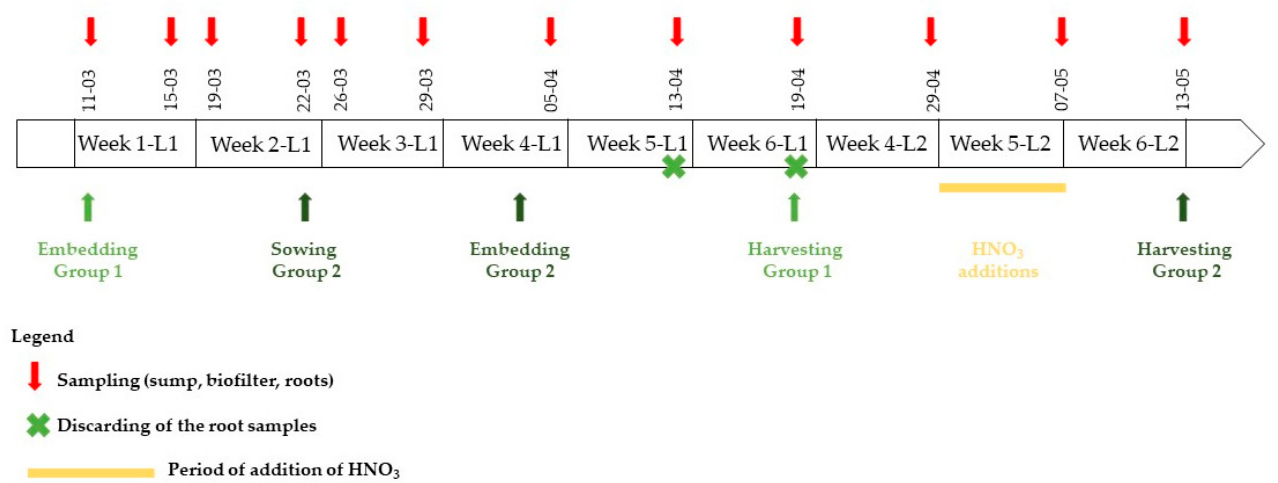
Figure 2. Timeline of the experiment. Samplings were conducted in the four compartments simultaneously and are indicated by a red arrow. The first lettuce group was sown on 28 February 2019 and embedded on March 11. In parallel, a second group of lettuces was sowed on March 22 and embedded on April 3. Root samples from the first group of lettuce, which were collected on April 13 and 19 were discarded as the lettuces appeared diseased (Supplementary Materials, Figure S1). All lettuces from group 1 were then discarded and the focus of the study was shifted in group 2 starting from April 29.